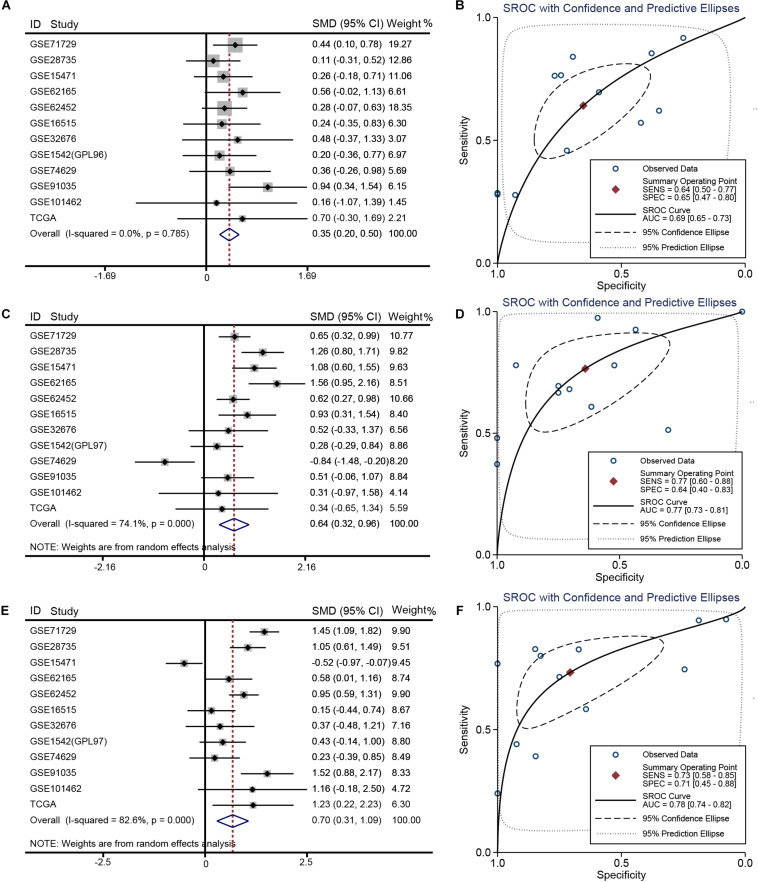
Meta-analysis of 12 datasets of pancreatic cancer. (A) Forest plot showing SKA1 expression difference. (B) sROC curve of SKA1. (C) Forest plot showing SKA2 expression difference. (D) sROC curve of SKA2. (E) Forest plot showing SKA3 expression difference. (F) sROC curve of SKA3.